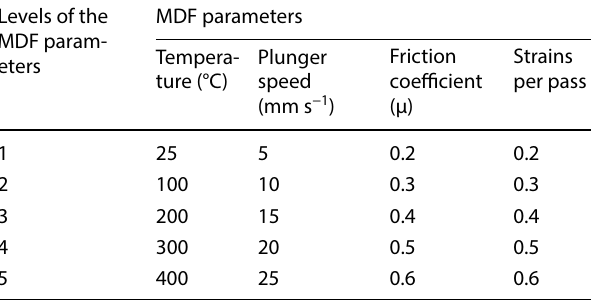
Table 1 MDF input parameters and their respective levels Levels of the MDF param- eters